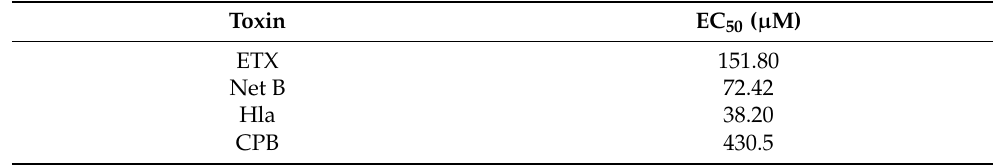
Table 2. The EC 50 (concentration for 50% of the maximal effect) value for ZA against pore-forming